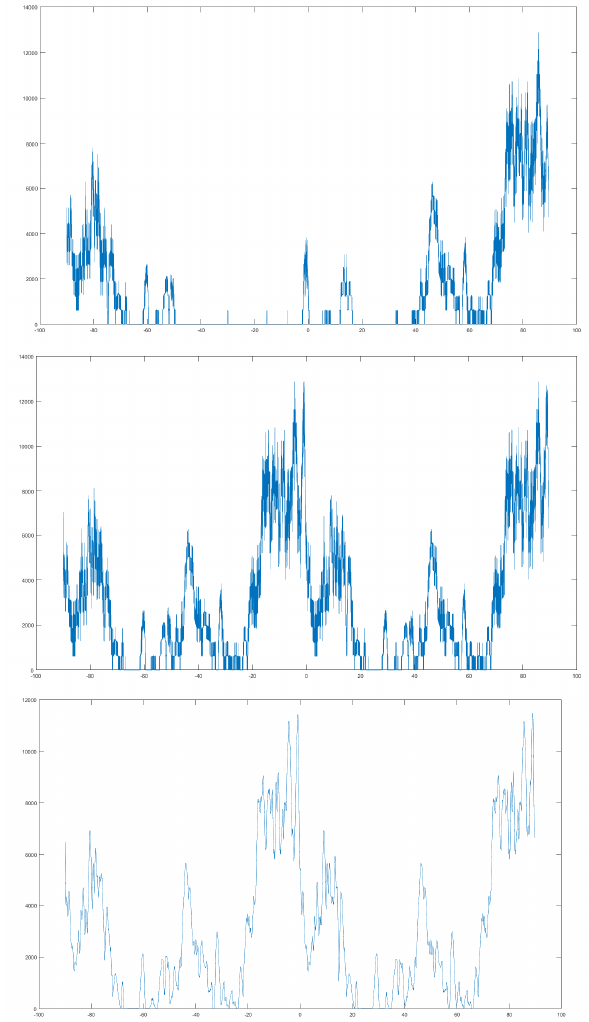
Figure 5. Estimation of in-plane rotation. Top: vector f (accu- mulation of thresholded HT diagram). Middle: vector g (conca- tenation of f and its 90º-shifted version; note the 90 o symmetry). Bottom: convolved vector; its argmax gives the optimal estima- tion of the in-plane angle of rotation (in this case it is -1º.02).